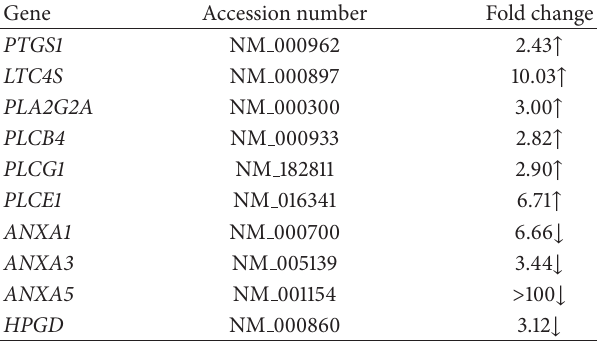
Table 3: Proinflammatory cytokines/chemokines regulated by SF in the Taqman 96-well plate array. Results are expressed as fold above